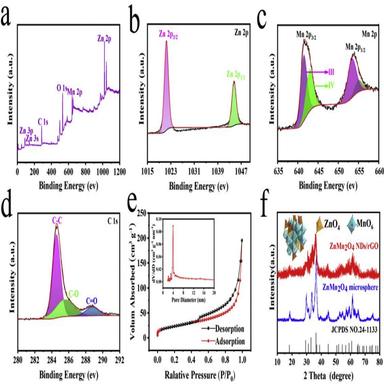
(a) XPS survey spectrum of the ZnMn2O4 NDs/rGO composite and corresponding high-resolution XPS spectra of (b) Zn, (c) Mn and (d) C elements. (e) N2 adsorption/desorption isotherm of the ZnMn2O4 NDs/rGO composite and inset the corresponding pore size distribution. (f) XRD patterns of the ZnMn2O4 NDs/rGO composite and pure ZnMn2O4 microspheres and inset the crystal structure of ZnMn2O4 spinel.